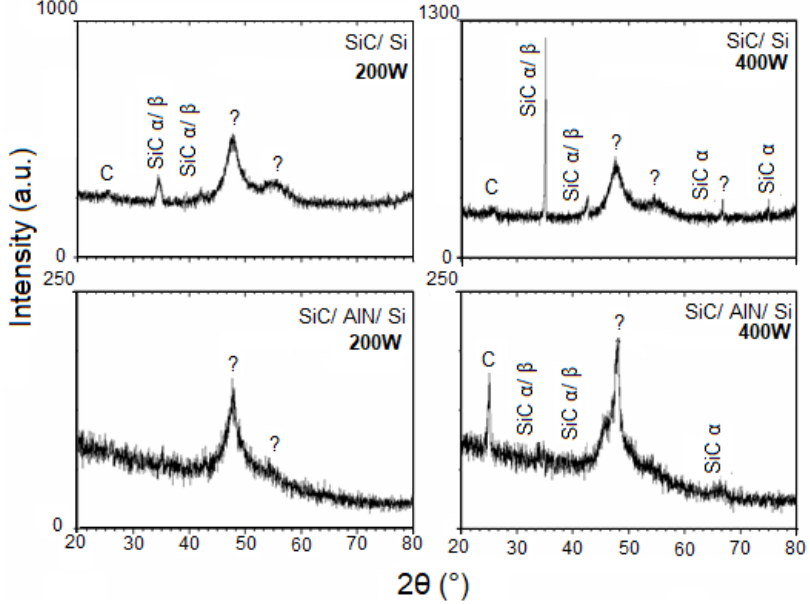
Figure 2. Grazing incidence X-ray diffraction (GIXRD) patterns of the SiC thin films at a grazing angle of 1.0°.